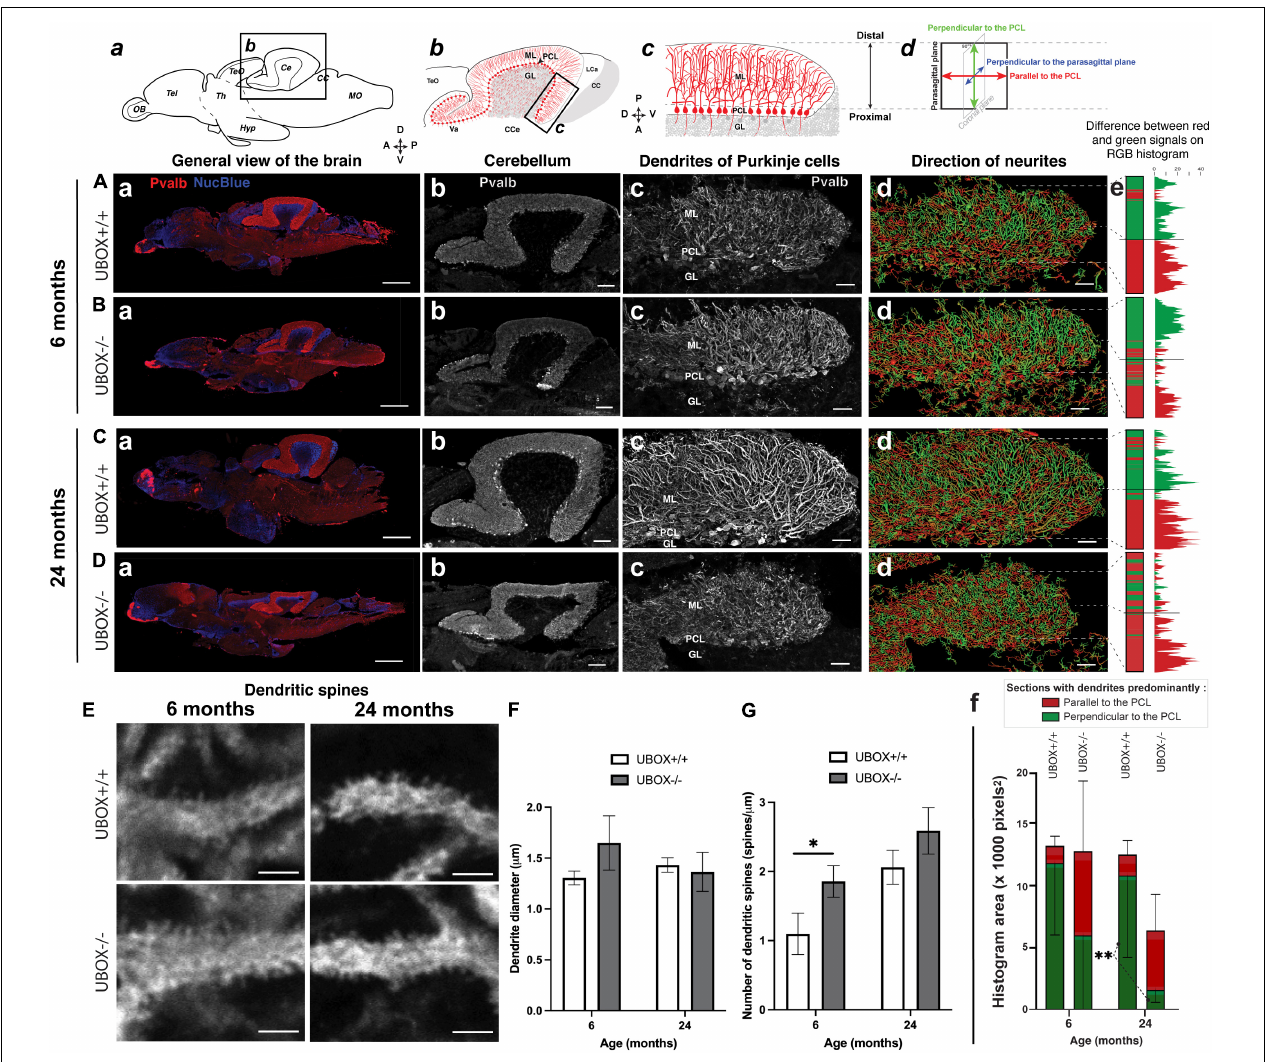
FIGURE 6 | U-box − / − mutants present a progressive dendrite arbor disorganization and an initial increase in dendritic spines. (A–E) Fluorescent immunohistochemistry on 8 µ m sagittal cryosections of wild-type ( A,C, and top E ) and mutant ( B,D , and bottom E) fish using Parvalbumin as a marker for Purkinje cells. The diagrams on top of (a–d) columns show the localization, orientation and structure of the underlying pictures. (A–Da) are slide scanner acquisitions showing the general anatomy of the brain, and (A–Db) are close-ups of the cerebellum from the same pictures. (A–Dc) are maximum z-projections of confocal stacks centered on the molecular layer of the posterior cerebellum, and (A–Dd) are the 3D renderings of neuronal tracing analysis on the stacks presented in c. The adjacent color bars on the right (e) highlight trends in the dendrite orientation along the proximal-distal axis of the molecular layer, each quantified as the histogram area for the distal part of the molecular layer and indicated time points (f) . (E) pictures are single confocal sections presenting a zoomed view of dendritic spines in the median to distal areas of the molecular layer. (F,G) present quantification results of the dendrite diameter (F) and the number of dendritic spines (G) at the two time-points as means ± standard deviations ( ∗ p < 0.05 and ∗∗ p < 0.01, Student’s t -test). Scale bars in (A–D) : 400 µ m in a, 100 µ m in b and 30 µ m in (c–d) . Scale bars in (E) : 2,5 µ